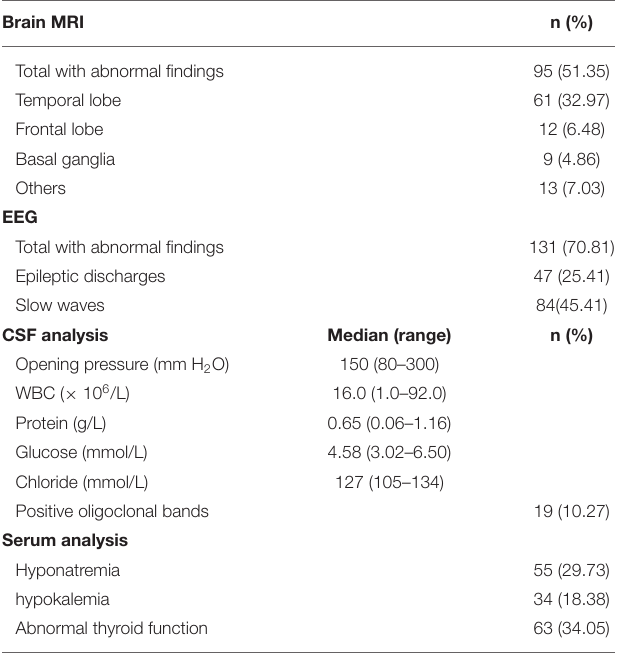
TABLE 2 | Summary of the main ancillary tests results ( n =